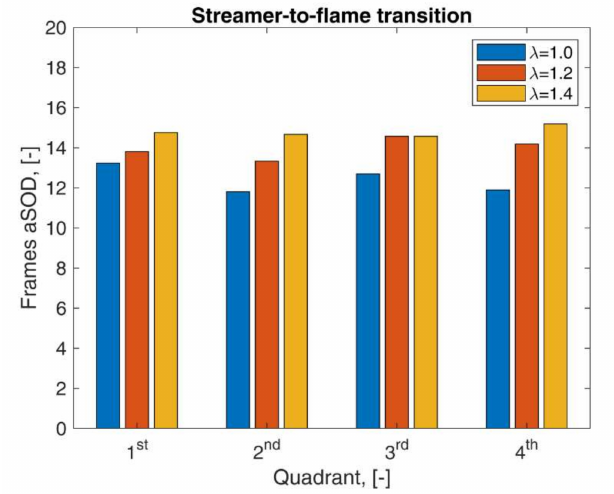
Figure 13. Distribution of the frame aSOD in which streamer-to-flame transition occurs. Bars refer to the average value (among the 63 events recorded for each test